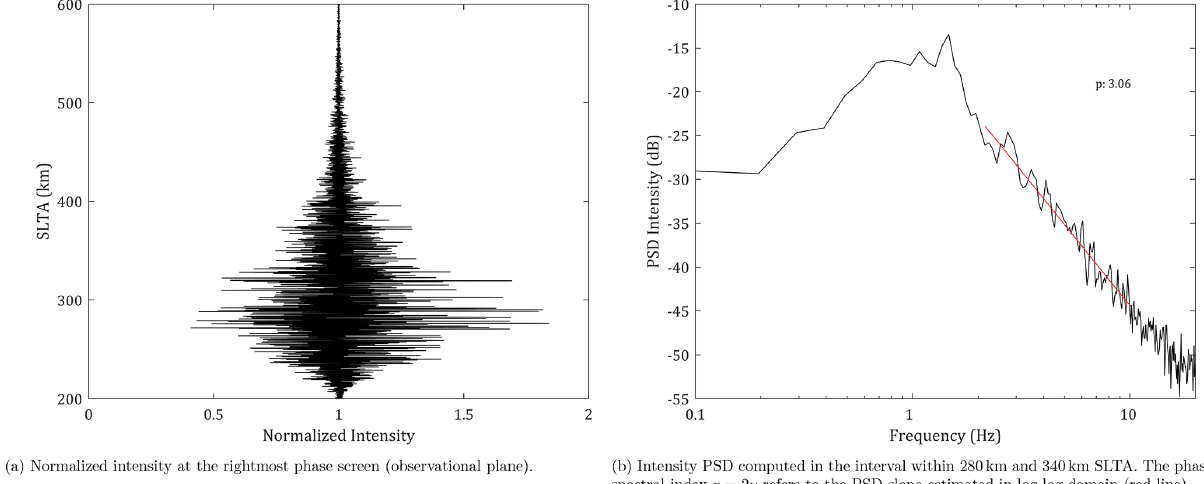
Figure 5. WOP results considering the set of parameters described in Carrano et al. (2011). The original C/NOFS measurement had an average SNR level of around 1500VV − 1